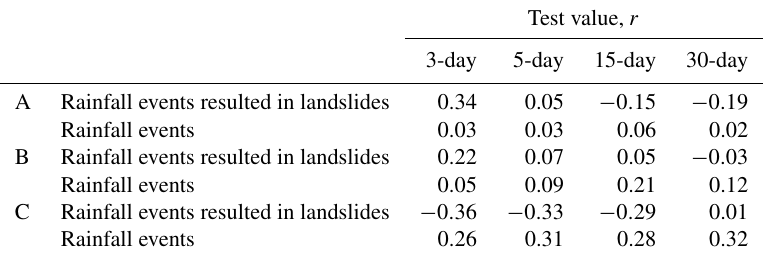
Table 6. Results of the Pearson test for the correlation between MAP-normalized cumulated rainfall and the MAP-normalized antecedent rainfall, for periods of 3, 5, 15 and 30 days before the rainfall events that have resulted ( L ) and have not resulted ( R ) in landslides, for the Borzone (A), Panesi (B) and Pian dei Ratti (C) rain gauges. See Fig. 1 for location of the rain gauges.